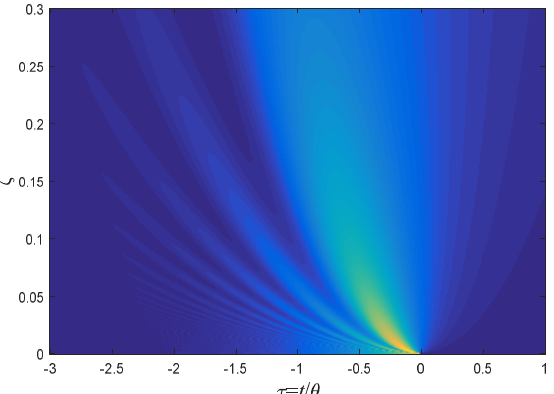
Figure 10. The real (upper panel) and imaginary (lower panel) components of the exponential-step function pulse (Equation (36)). The dashed curve represents the initial profile (for 0/ 2 while the solid curve represents its final shape (for 01.0/ 2